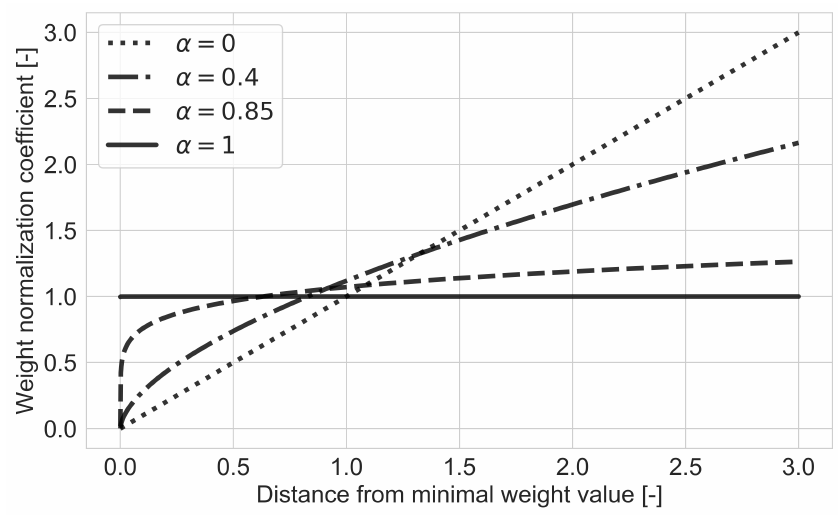
Figure 9. Inherent adaptive weight normalization coefficient L α ( w ji − c ) of